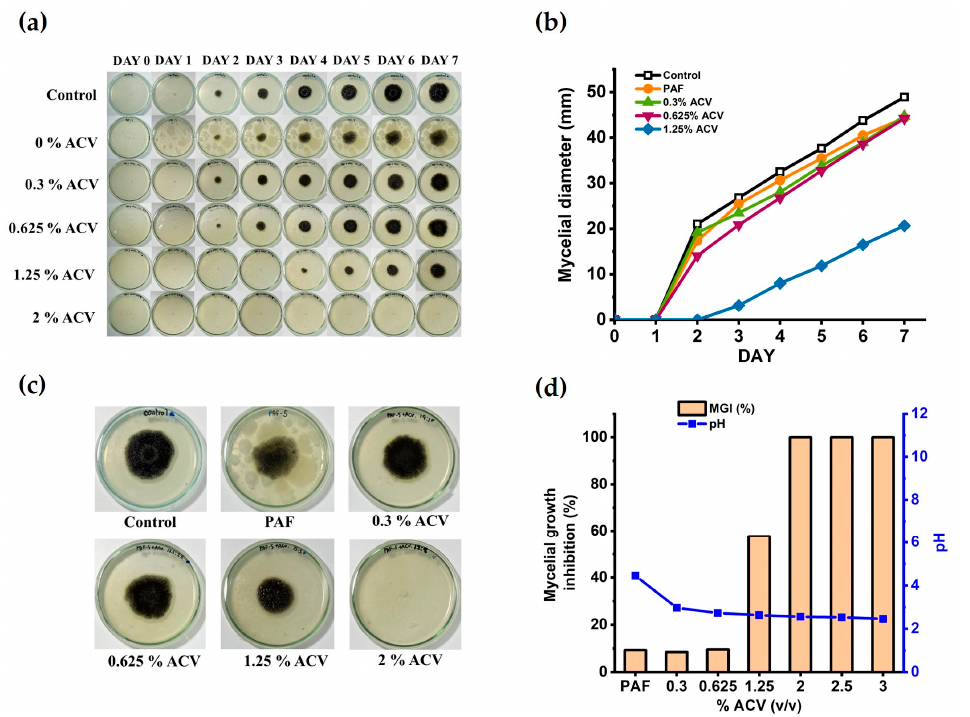
Figure 2. The mycelial growth of A. niger on the adhesive on the agar medium was effectively inhibited by the addition of ACV at the optimum concentrations. ( a ) Seven-day monitoring for any microorganism growth in the PAF and ACV/PAF water glues spiked with the A. niger fungi; ( b ) the measured mycelial diameter (mm) of the fungal growth; ( c ) the fungal growth after the seven-day storage under air exposure; ( d ) the percent of mycelial growth inhibition at various ACV concentrations in the adhesives and their